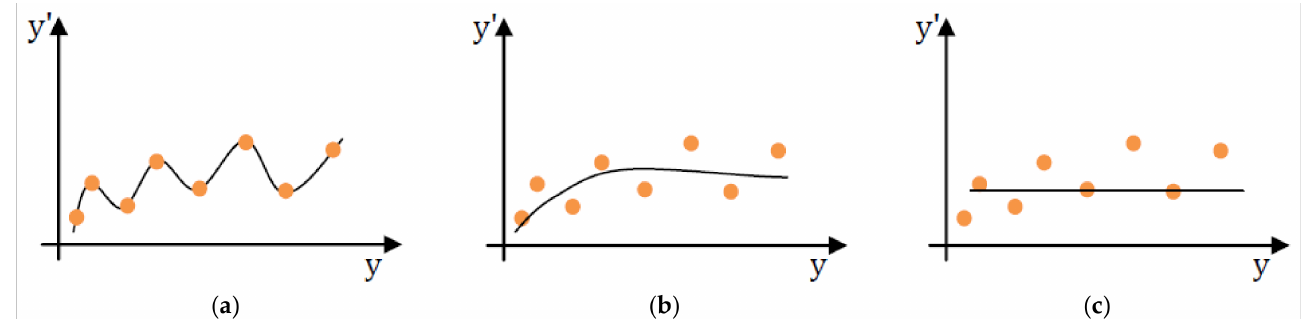
Figure 10. Fitting problems due to the selection of bias values. ( a ) Overfitting; ( b ) ideal fitting; ( c )